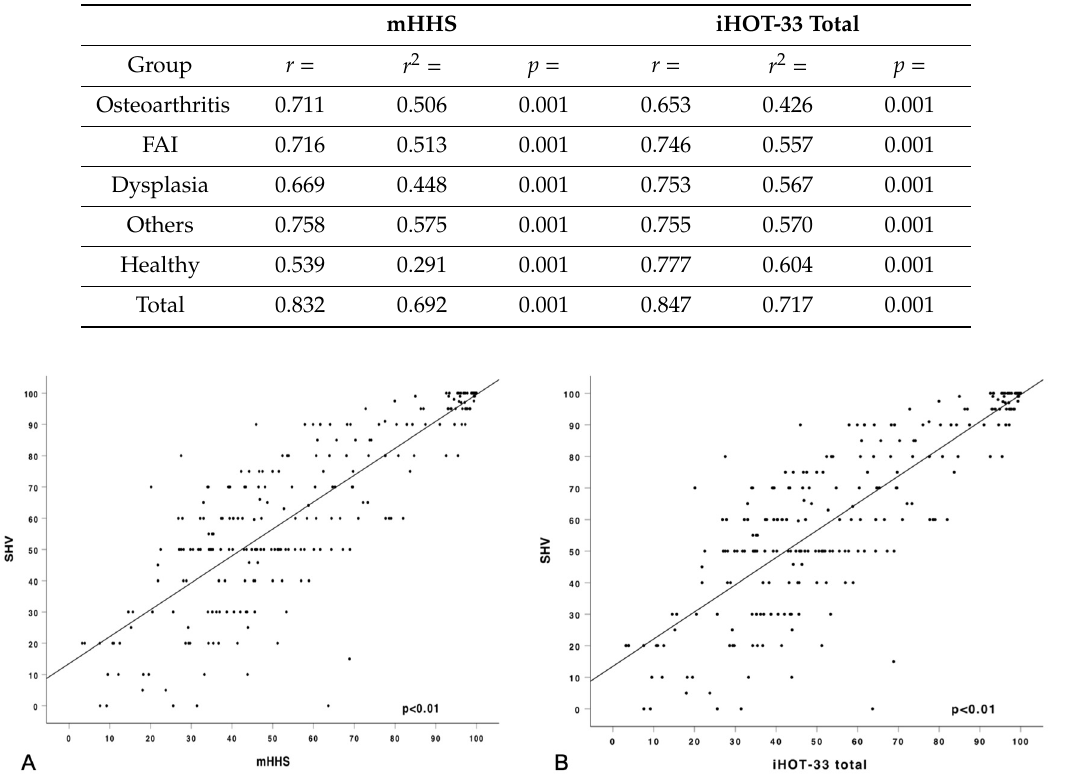
Figure 2. Pearson correlation of the subjective hip value (SHV) with ( A ) modified Harris hip score (mHHS) and ( B ) International Hip Outcome Tool (iHOT-33).